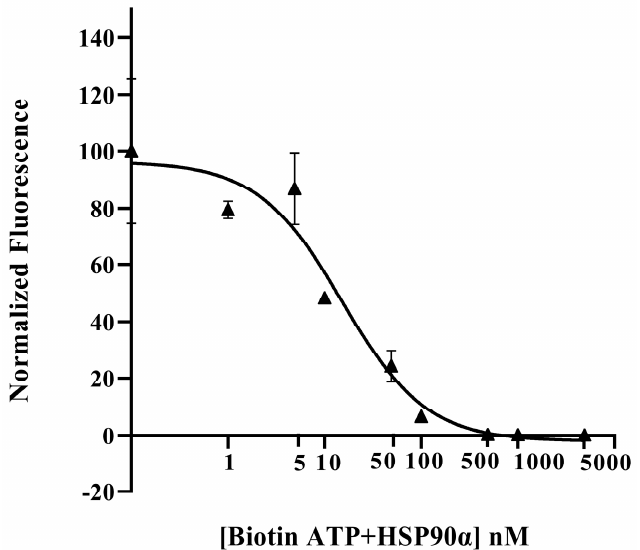
Figure 3. Fluorescence masking of Sav-QDs as a function of biotin-ATP and HSP90 α concentration. Concentration-dependent masking is fitted in a dose-responsive manner with an EC 50 value of 15.20 nM. Maximum fluorescence intensity is counted as 100%, which is only FP1 buffer. The concentration of spotted Sav-QDs was 100 nM. Parameters of the dose–response fitting, A1 = 0 nM, A2 = 5000 nM, slope = − 1.12, log X = 1.182, and X = 15.20. Normalized fluorescence is plotted against biotin-ATP and HSP90 α concentration.